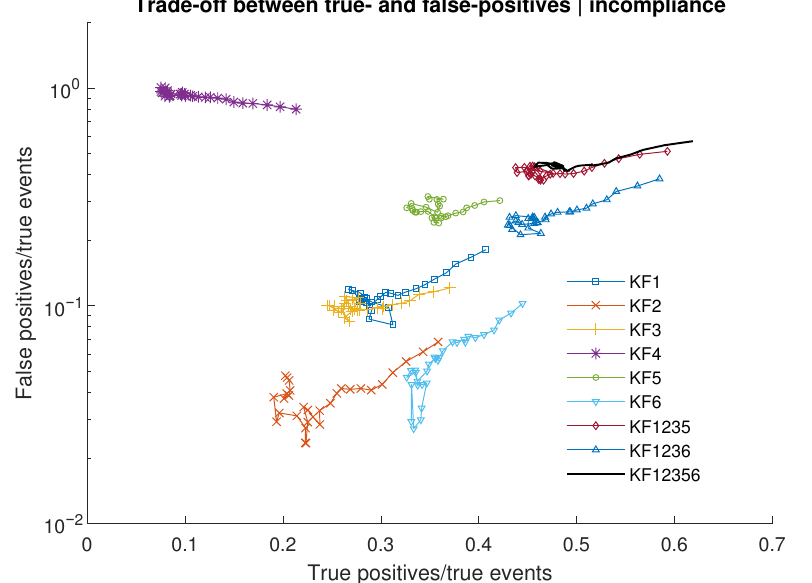
Figure 11. Trajectories of all methods in the true-positive rate—false-positive plane. Note the semi- logarithmic